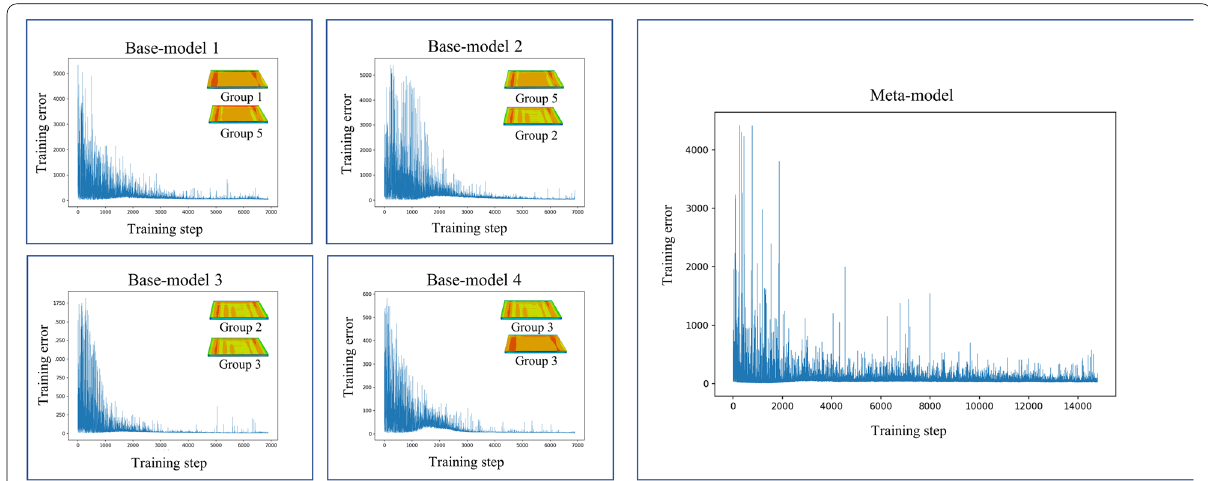
Fig. 10 Convergence curves in training process of Part 2